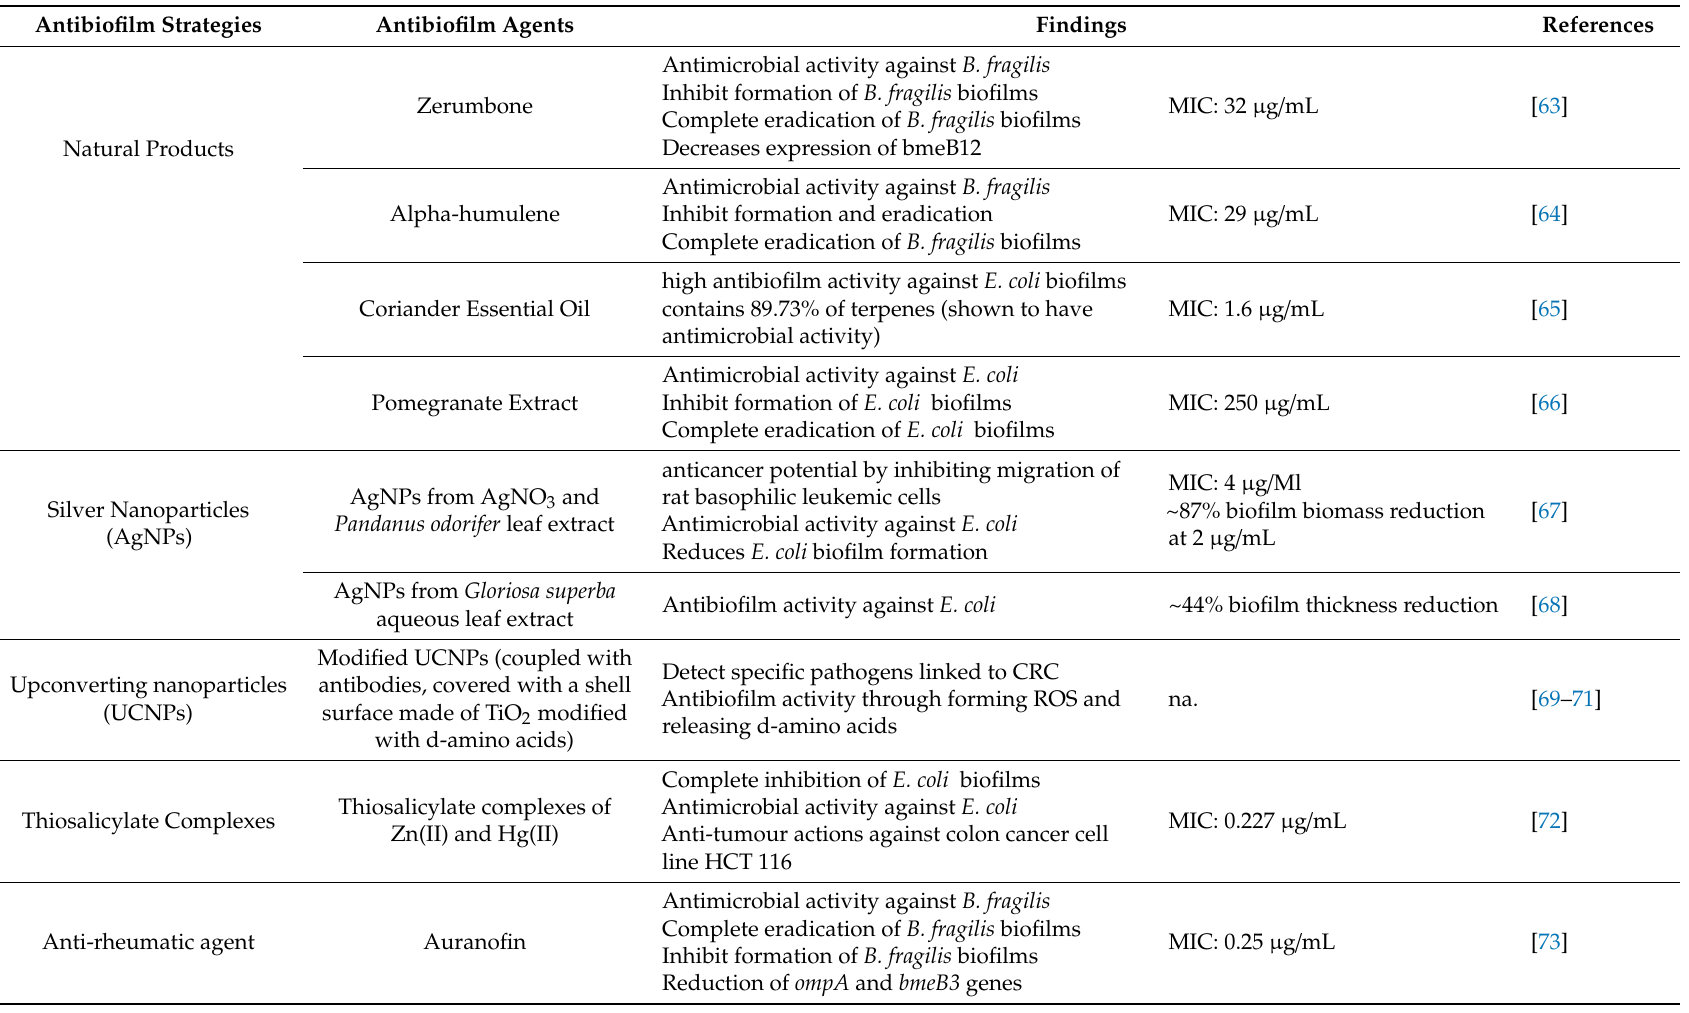
Table 1. Strategies to target gut microbial